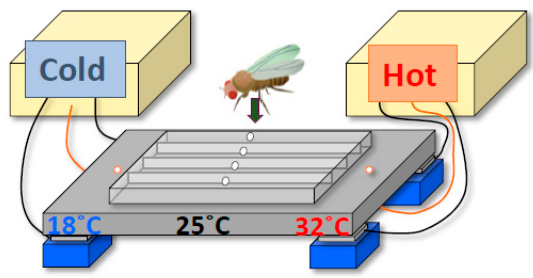
Figure 2. Drosophila temperature preference behavioral assay. A temperature gradient from 18 to 32 ◦ C is generated in a chamber made with a metal plate and a plexiglass cover. Flies are introduced into the chamber through the holes in the cover. Within 30 minutes, the flies settle in the locations with their preferred temperatures. Because their body temperatures are very close to the ambient temperature, their body temperatures can be determined by measuring the temperature in the place where they are located. The diagram is modified from Goda et al. 2014, Figure 3 [26]. 3. TPR is Controlled by the Noncanonical Clock Circuits via Dorsal Neurons 2 (DN2s)